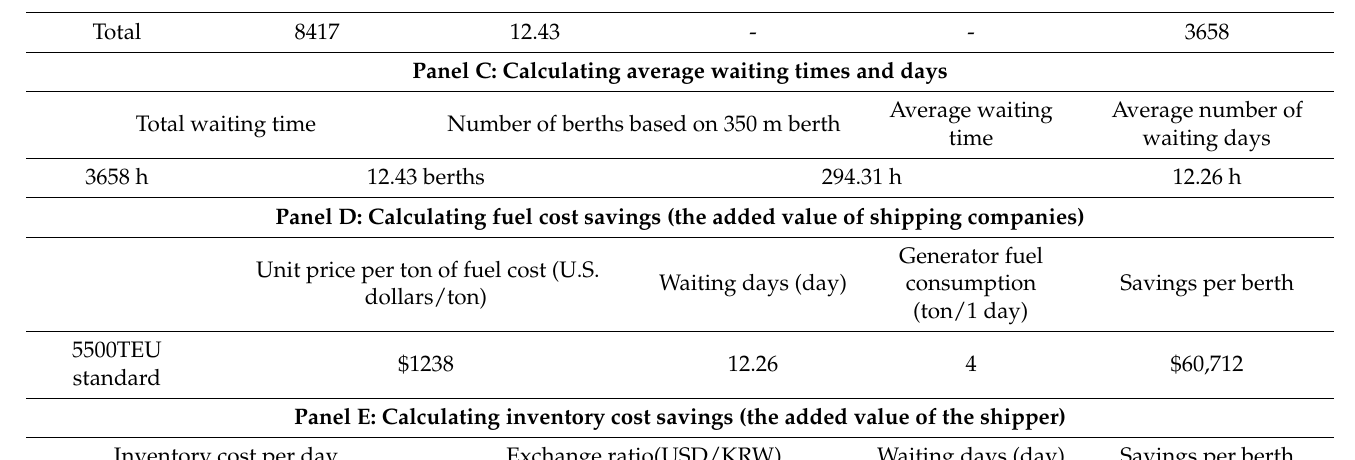
Panel C: Calculating average waiting times and days